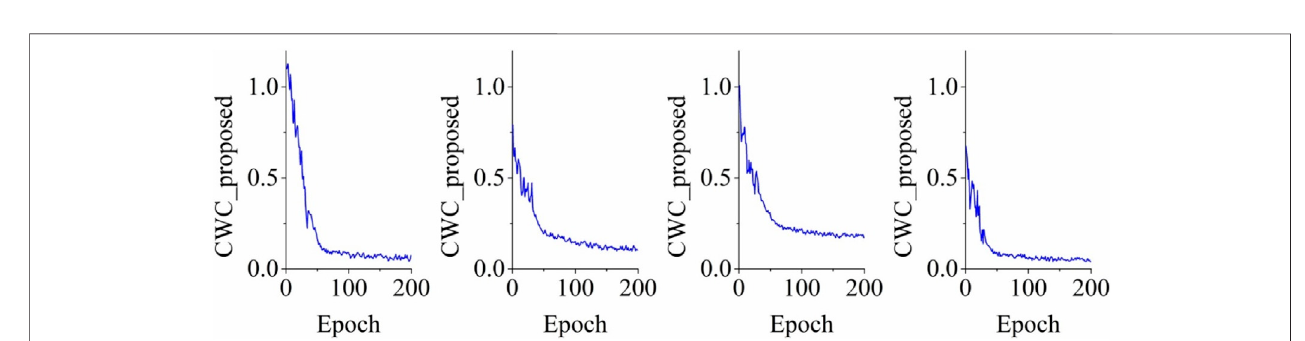
FIGURE 9 | Training KELM on the four case study buildings using proposed